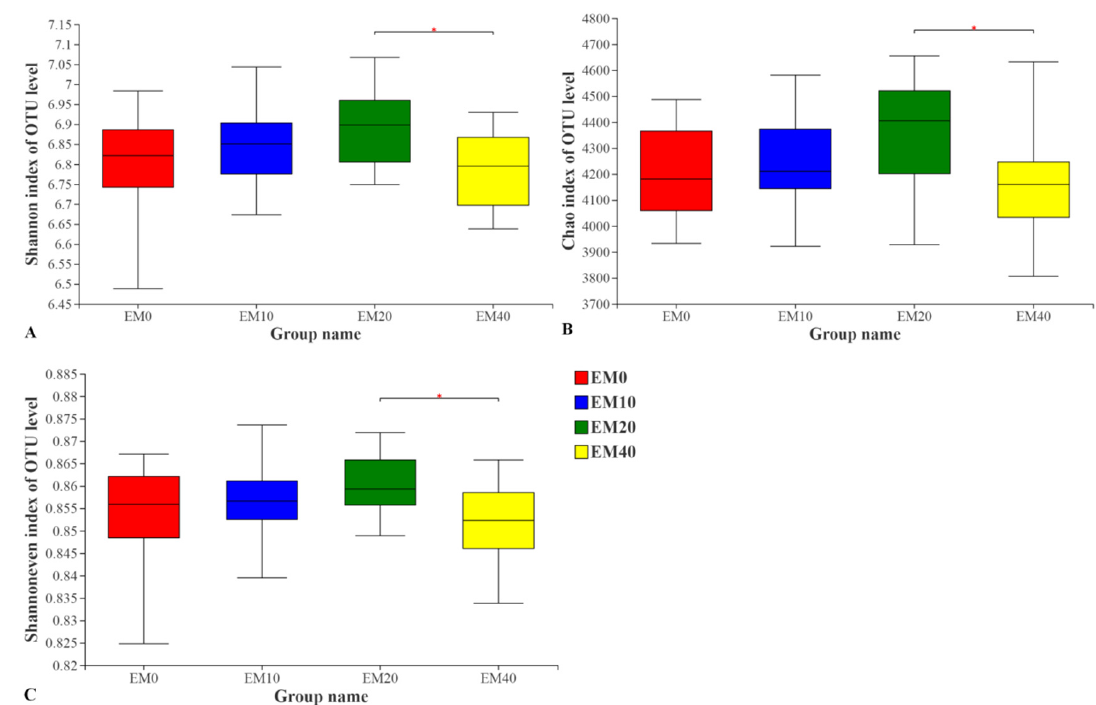
Figure 2. Alpha diversity index statistics of rhizosphere microorganism of F. chinensis in different treatments. ( A ) Shannon index of OTU level; ( B ) Chao index of OTU level; ( C ) Shannoneven index of OTU level. Note: p < 0.05 is marked as asterisk.